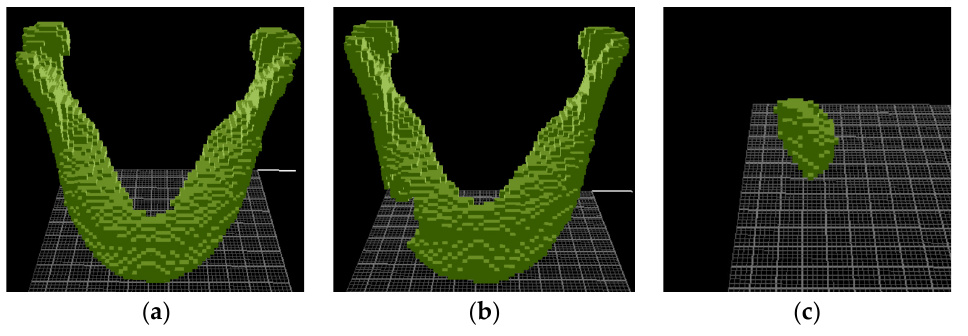
Figure 5. Three-dimensional model in 64 × 64 × 64 dimensions. ( a ) Voxelized 3D model ( b ) Simulated 3D model of defect ( c ) Implant 3D model.